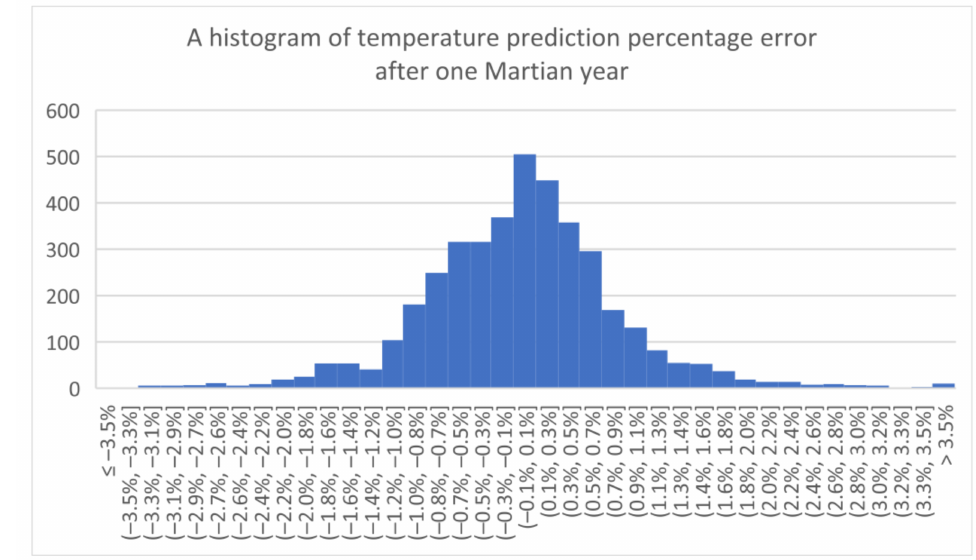
Figure 9. A histogram of temperature prediction percentage error after one Martian year.